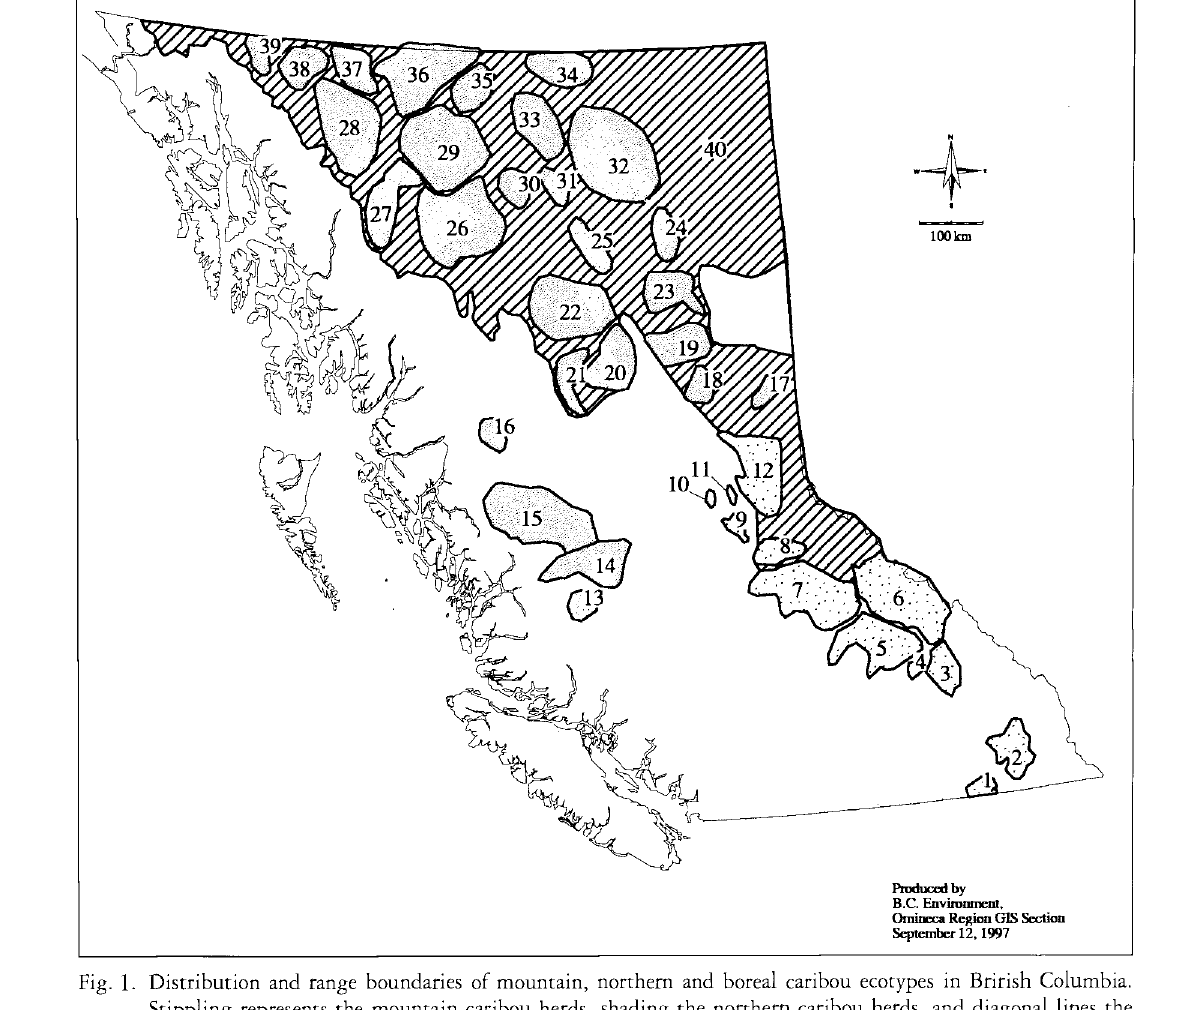
Fig. 1. Distribution and range boundaries of mountain, northern and boreal caribou ecotypes in Brirish Columbia. Stippling represents the mountain caribou herds, shading the northern caribou herds, and diagonal lines the areas of low caribou density and, in the northeast, where caribou do not appear to occur in denned herds (i.e., the boreal